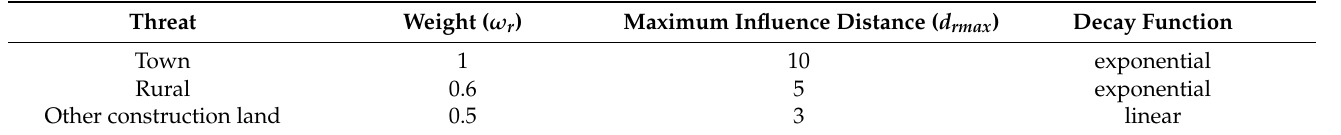
Table A2. Relative weight, maximum influence distance, and decay function of threats.